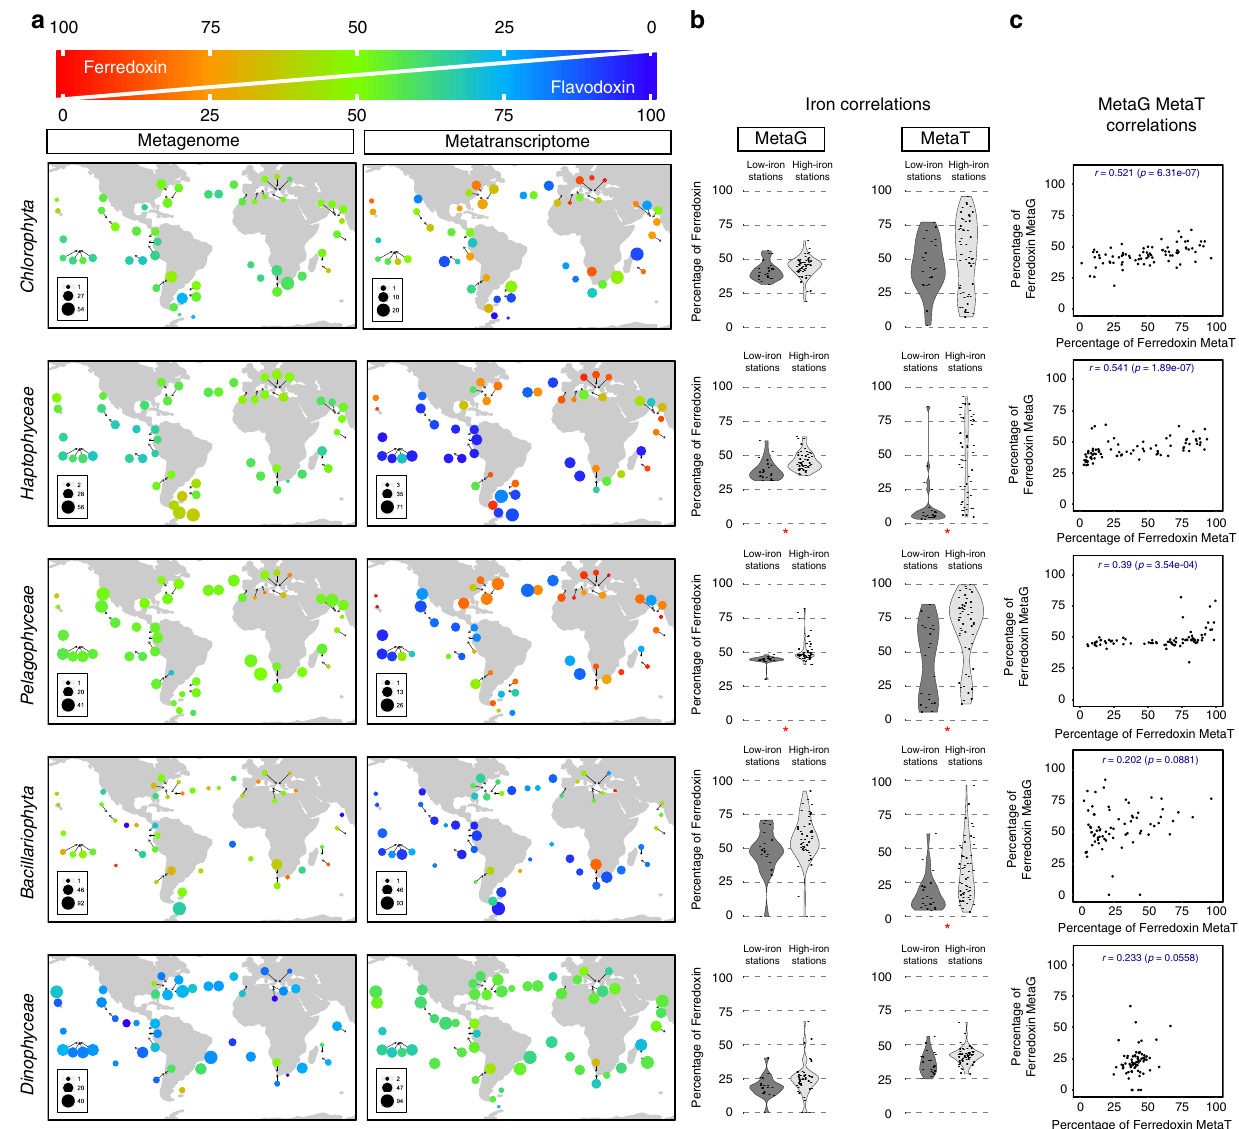
Fig. 6 Ratios of differential gene abundance and relative expression of ferredoxin vs. fl avodoxin in the fi ve major photosynthetic groups. a Representation of the relative abundance (left) and expression (right) of the two genes identi fi ed in surface samples for Chlorophyta , Pelagophyceae , Haptophyceae (from 0.8 to 5 µ m fi lters), Bacillariophyta and Dinophyceae (from the 5 to 20 µ m fi lters). The circle colors, from red to blue, represent the relative expression of one gene compared to the other, with the color code given in the top diagram. The sum of the expression levels of the two genes af fi liated to each taxonomic group is represented by the circle diameter as a percentage of the total expression of these genes. b Distribution of the relative abundance (left) or expression (right) of ferredoxin in low iron stations ( < 0.02 µ mol m − 3 , 15 stations, dark gray) or iron rich stations ( > 0.2 µ mol m − 3 , 31 stations, light gray) according to a model of iron concentration in the oceans (Supplementary Data 5). Signi fi cant differences of expression between low and rich iron stations are indicated with red stars (non-parametric wilcoxon rank-sum test, p < 10 – 3 ) c Correlations between the relative metagenome (MetaG) abundance and metatranscriptome (MetaT) expression of ferredoxin in SRF and DCM samples, expressed as a percentage of the total value of ferredoxin + fl avodoxin. Pearson correlation coef fi cients ( r ) and their statistical signi fi cance ( p ) are indicated in each graph. Ferredoxins and fl avodoxins were identi fi ed using the Pfams PF00111 and PF00258,